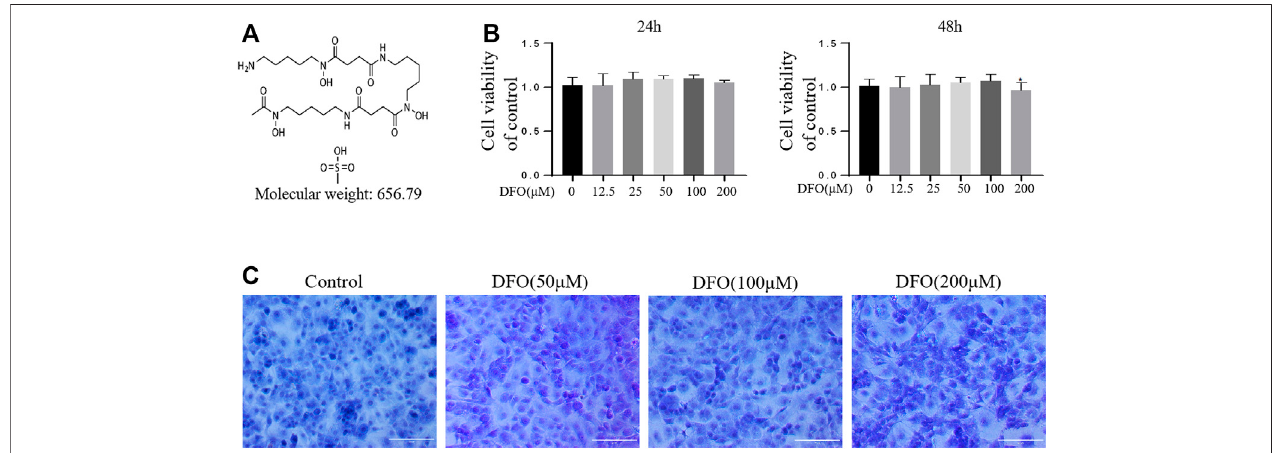
FIGURE 1 | Effect of DFO on the chondrocyte viability. (A) Chemical structure of molecular weight of DFO. (B) The cytotoxic effect of DFO (12.5, 25, 50, 100, and 200 μ M)onthechondrocyteswasdeterminedfor24and48 h.Thecolumnsrepresentthemeans±SD.* p < 0.05versusthecontrol, n =5. (C) Chondrocytemorphology is revealed by toluidine blue